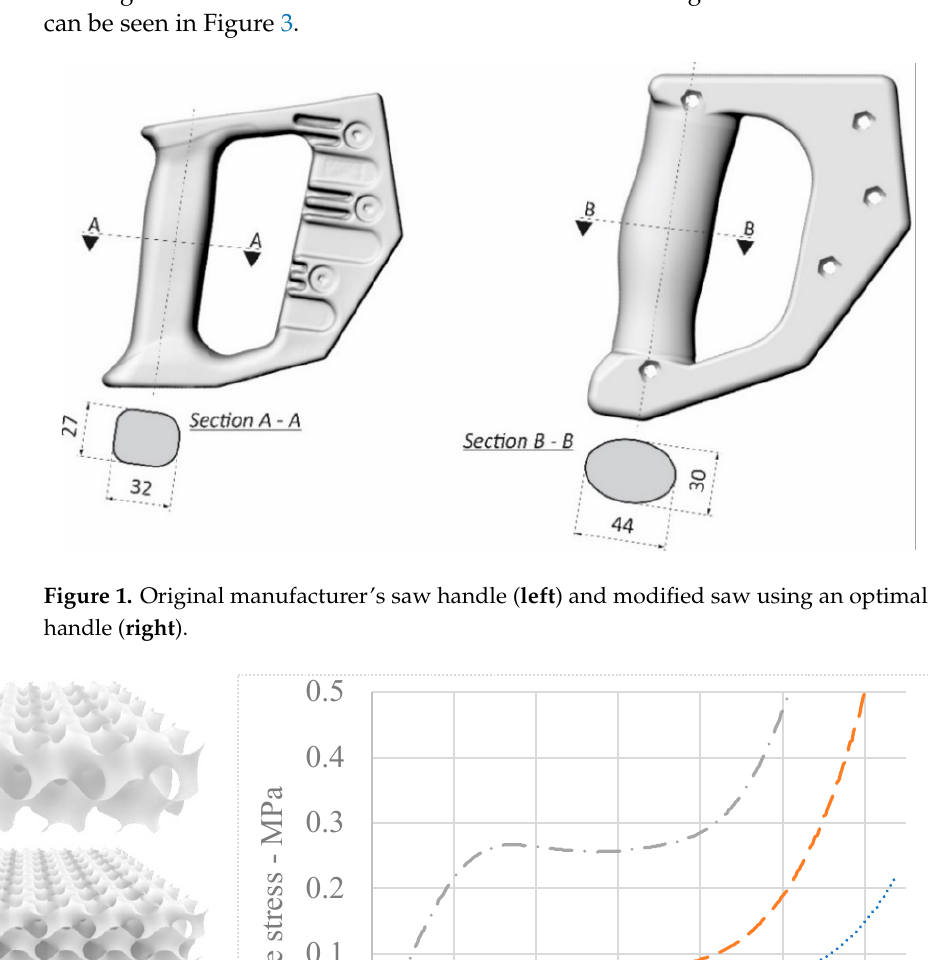
Figure 1. Original manufacturer’s saw handle ( left ) and modified saw using an optimally shaped handle ( right ).